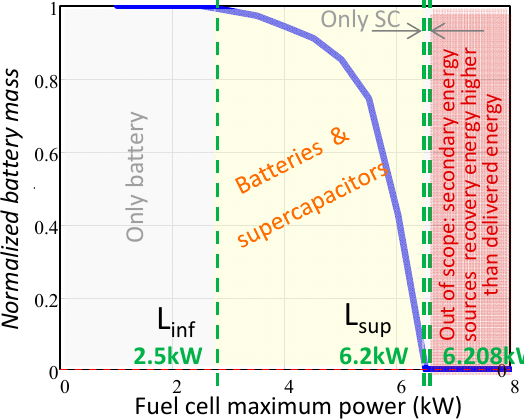
Figure 7. Normalized battery mass as a function of the fuel cell maximum power.